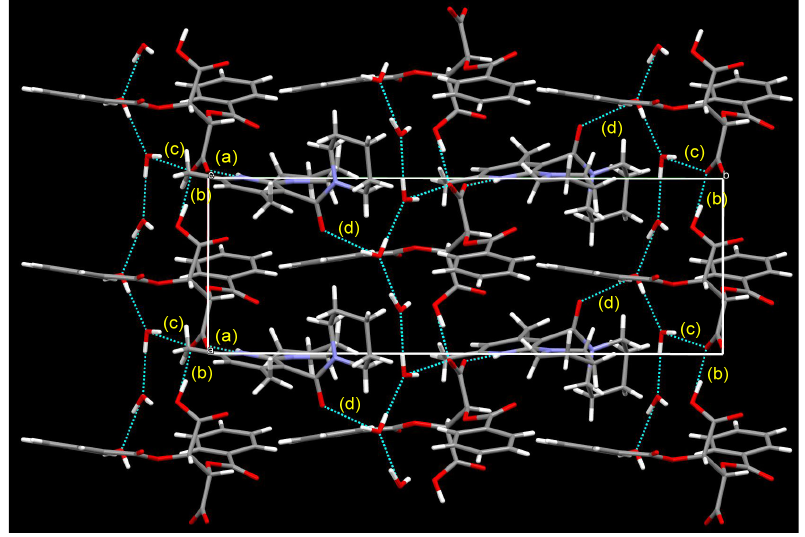
Figure 8. Packing diagram of (a R )- 1b , (+)- D -DBTA and 3H is shown along with the b -axis. Four types of hydrogen bond (other than the hydrogen O molecules) were observed: (a) NH(pyridinium)---O=C (DBTA): bonds between two H 2 2.01 Å, (b) C(=O)OH (DBTA)---O(O=)C (DBTA): 1.53 Å, (c) O(O=)C (DBTA)---HOH: 2.08 Å, (d) NC=O---HOH: 2.08